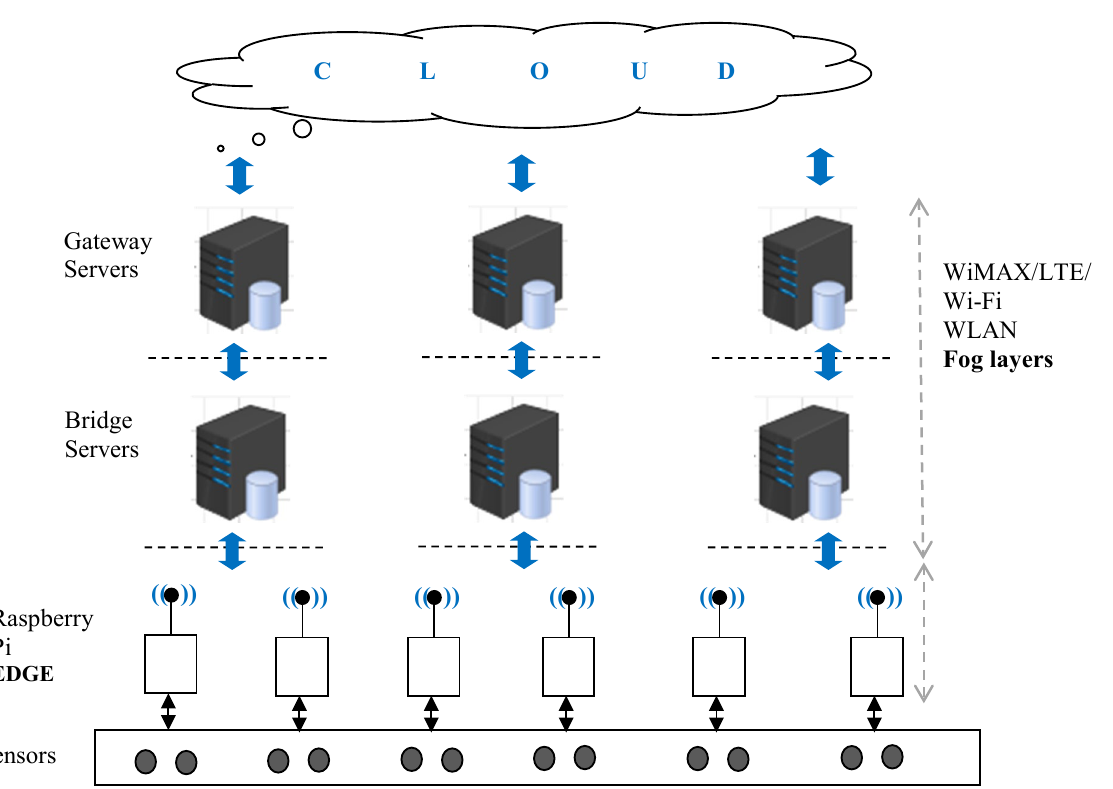
Fig. 2. IIoT platform in Edge-to-Fog WLAN-to-Cloud. It is the implementation of a 5-level lightweight communication model.